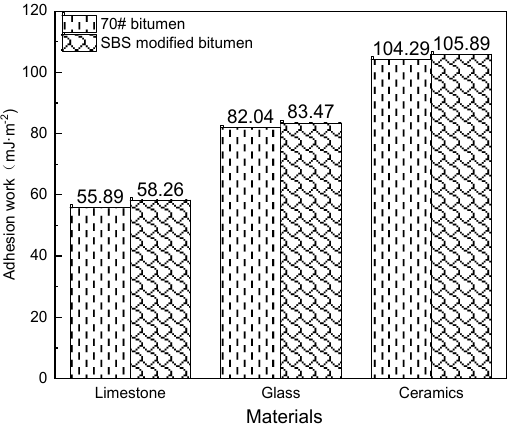
Figure 11. Adhesion work between bitumen and aggregates.